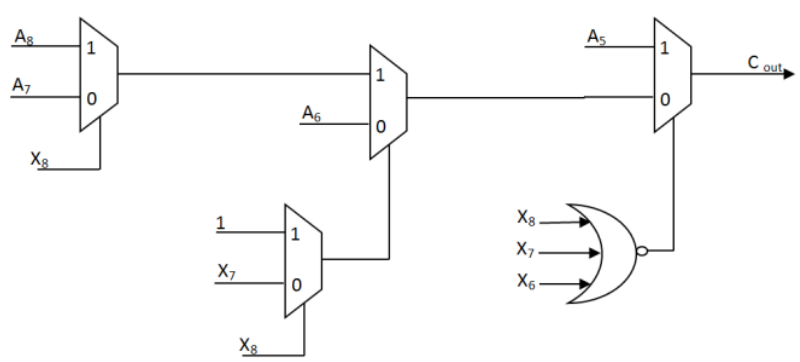
Figure 8. The circuit producing output carry for the second four bits in the circuit producing the eighth bit carry